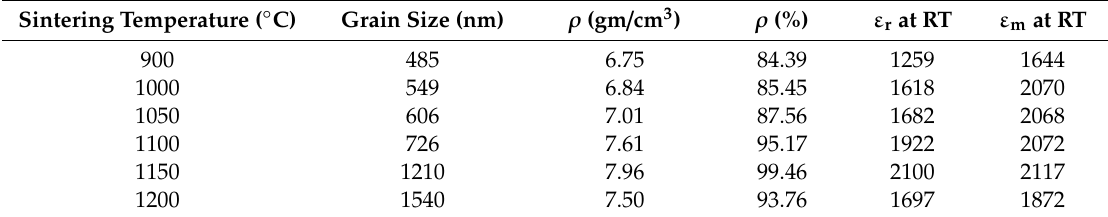
Table 1. Microstructural and dielectric properties of microwave sintered PLZT 8 / 60 / 40 ceramics, measured at 1 kHz, room temperature